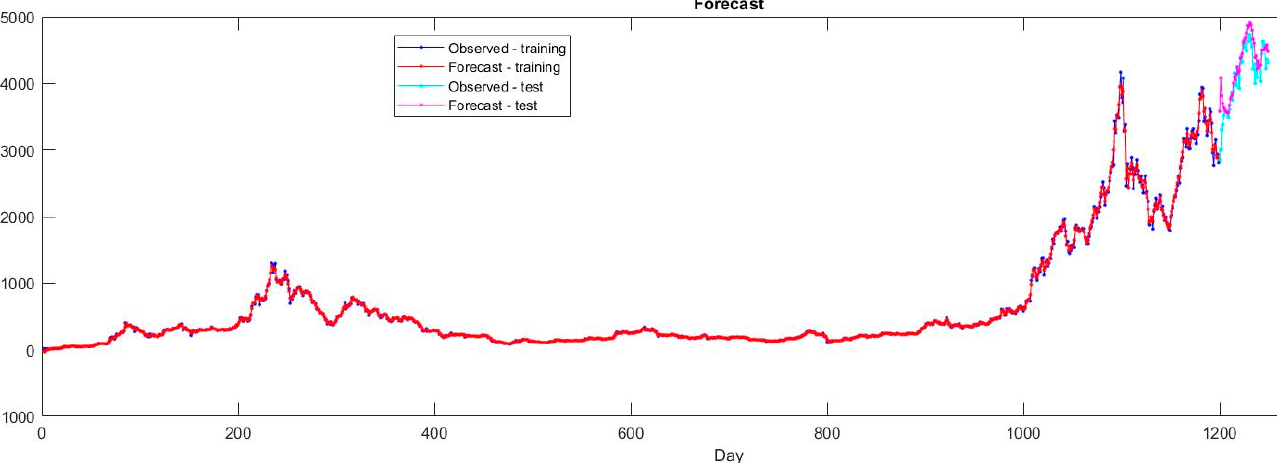
Figure 23. ETH–USD: ES-LSTM training.